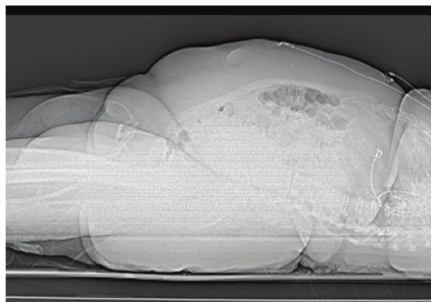
Figure 1: Reconstructed surface view of abdominal and pelvis illustrating patients with high body mass index.